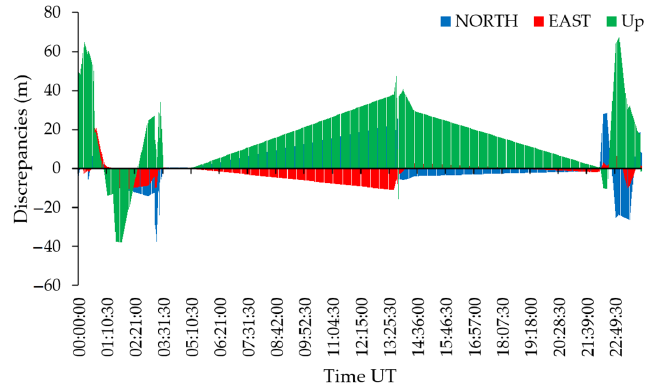
Figure 11. Plot of discrepancies of station SALP on 14 July